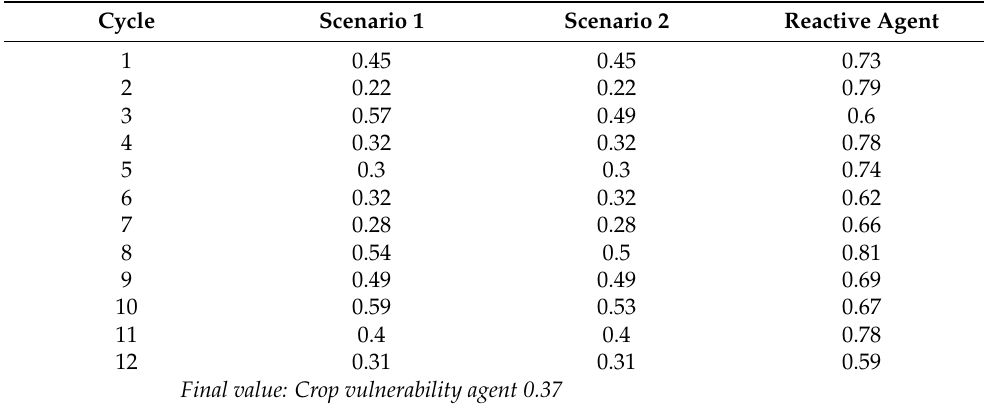
Table 7. Crop vulnerability